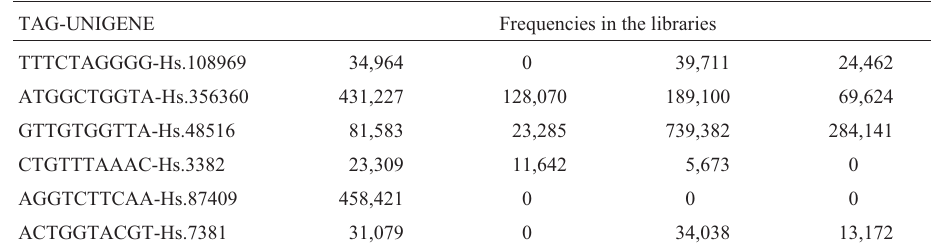
Table 1 - Portion of the main